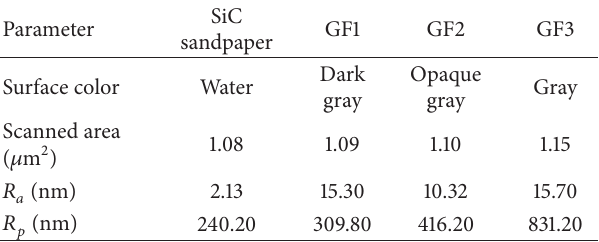
Table 1: Finished parameters from graphite samples.